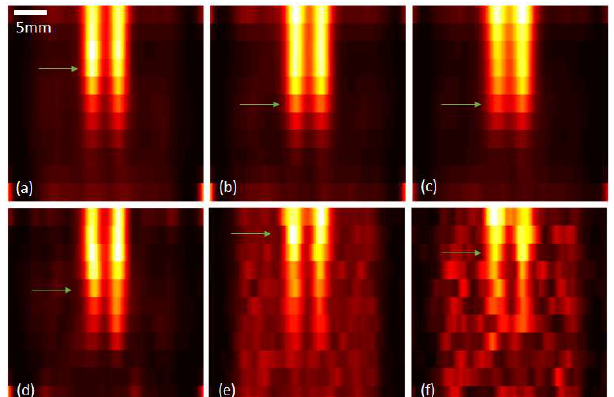
Figure 4. Vertical sectional images of nine pinholes of MP geometry with ( a ) 5 cm OPD and 5 cm PDD, ( b ) 5 cm OPD and 3.5 cm PDD, ( c ) 5 cm OPD and 2.5 cm PDD, ( d ) single pinhole of MP geometry with 5 cm OPD and 5 cm PDD, ( e ) 9 pinholes and ( f ) single pinhole of PMP geometry with 5 cm OPD and 5 cm PDD. Results are shown along the red dashed line in Figure 2d. Single pinhole is P22 in Figure 2a. The green arrows point to the layers the two inserts are separating.